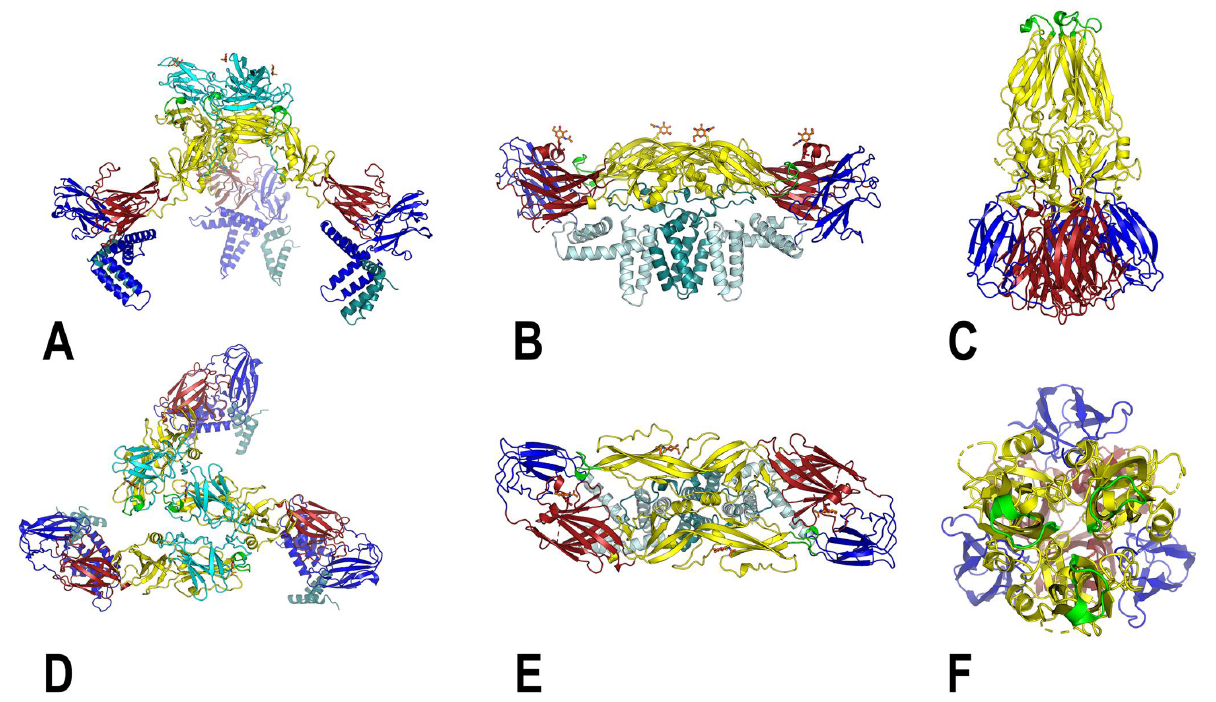
Figure 2. Models of the flavivirus structural proteins corresponding to various stages in the virus life cycle. ( A – C ): Immature DENV1 trimer, mature USUV dimer and the fusogenic DENV hairpin conformation, respectively. Corresponding top views are depicted in ( D – F ), respectively. For the immature E trimer and the E dimer, the E-stem region is also shown. The models are color coded as follows: DI (red), DII (yellow), DIII (blue), fusion loop (green), glycosylation sites (orange) and prM (cyan); for ( B , E ), the E-stem is in light blue and M protein is in